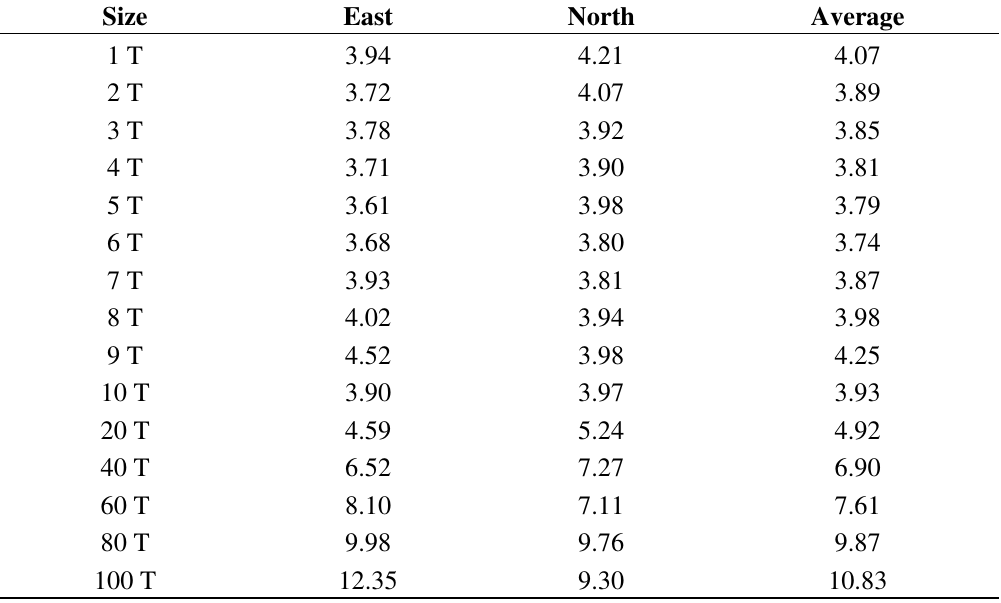
Table 6. Relationship between smoothing step and velocity RMSE (cm/s).